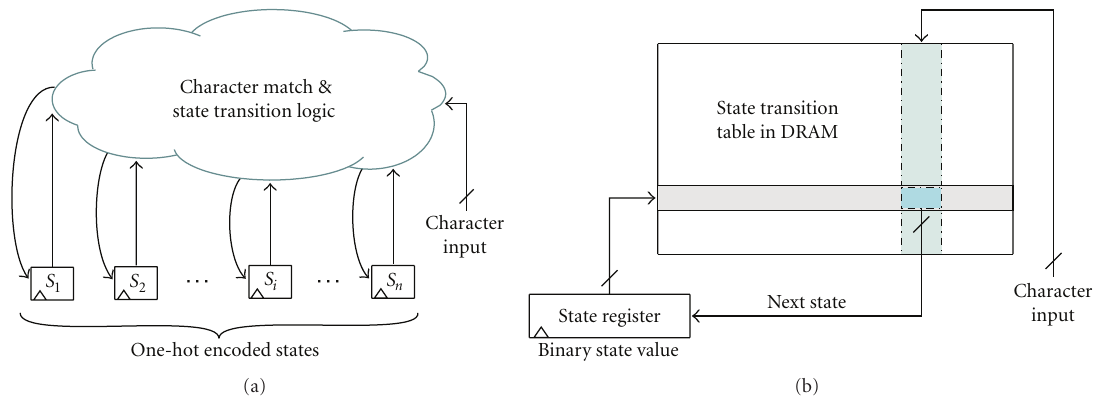
Figure 1: Basic architectures of RE-NFA (a) and RE-DFA (b). Our work focuses on regular expression matching using the RE-NFA